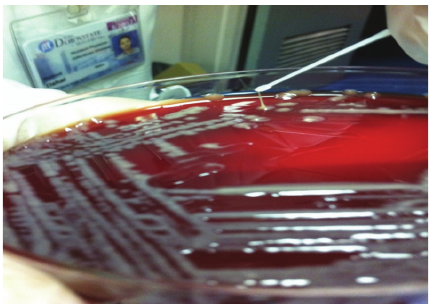
Figure 2: Image of positive string test result caused by rmpA K. Pneumoniae .